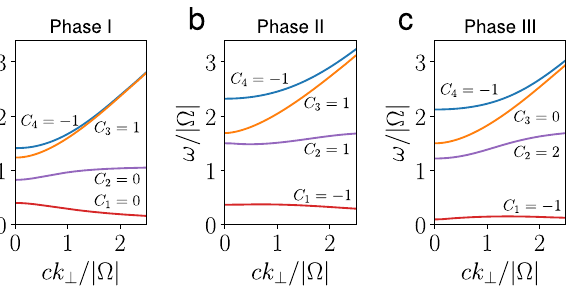
Fig. 3 Chern numbers. a – c Chern numbers of each positive frequency bands of the three phases of the phase diagram. Since the dispersion relation is isotropic in ( k x , k y ) plane, only the k ⊥ > 0 part is shown. The parameters used are Ω = 1 and ( ω p , ck z ) = (0.4, 1.2) in ( a ), (1.5, 1.2) in ( b ), and (1.5, 0.5) in ( c ), which are shown as black dots in Fig. 2b.